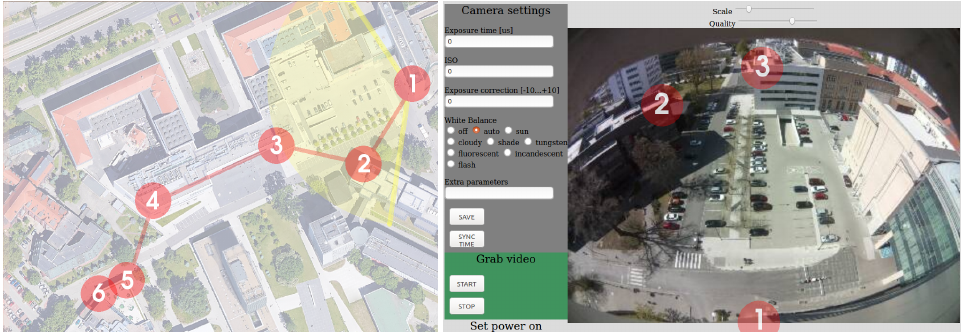
Figure 4. Deployment of the test system at university campus—camera locations and camera #1 FoV.